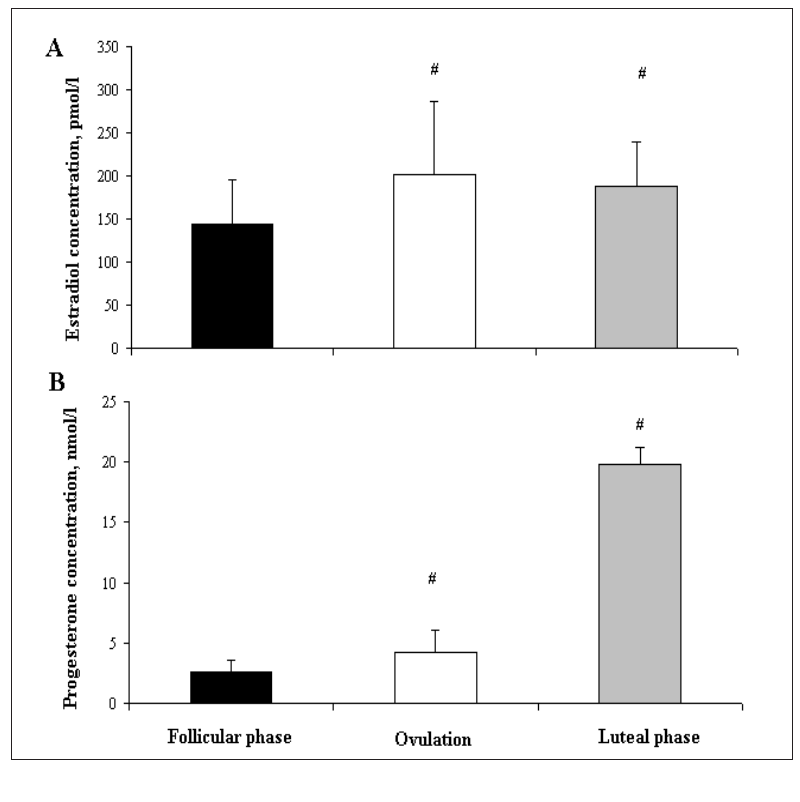
Figure 3. Female basketball players’ estradiol (A) and progesterone (B) concentration in blood during follicular, ovulation and luteal phases